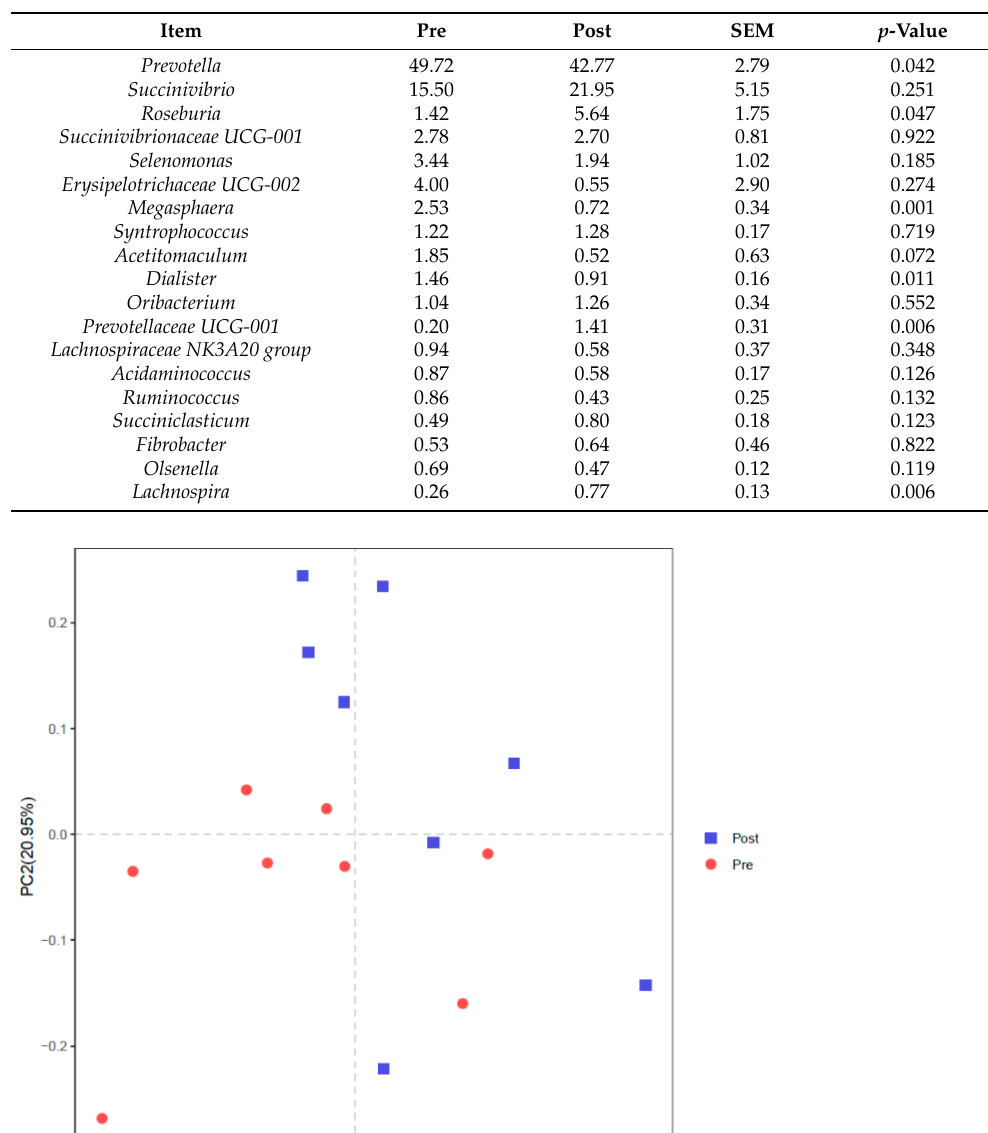
Table 6. Rumen bacterial community at the level of genus before (Pre) and after (Post) diet shift.